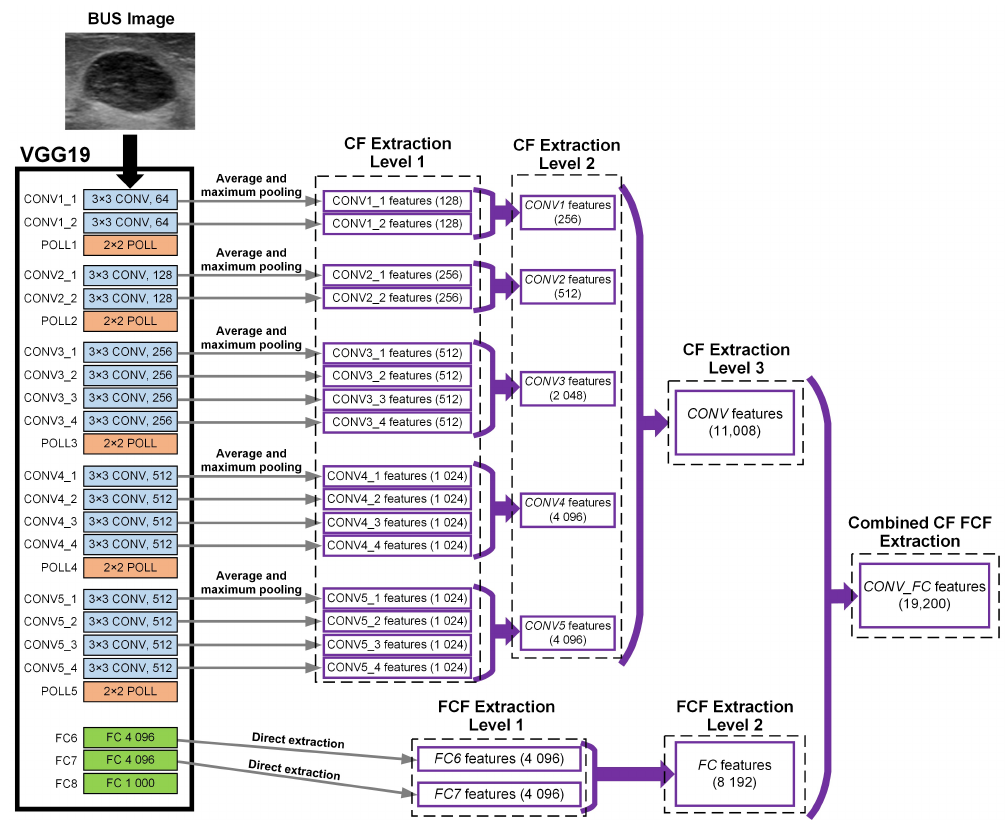
Figure 1. Graphical illustration of the process of extracting deep features from the ROI in the BUS image using the pre-trained VGG19